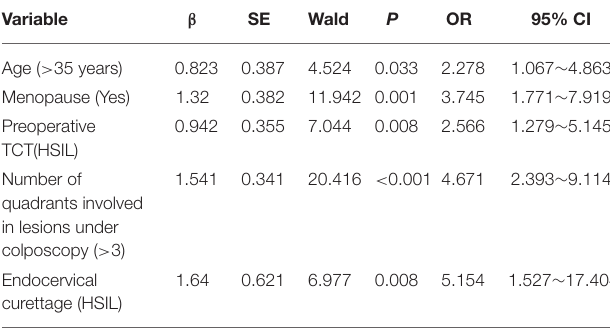
TABLE 1 | Single factor analysis of positive margins after LEEP. TABLE 2 | Multivariate analysis.